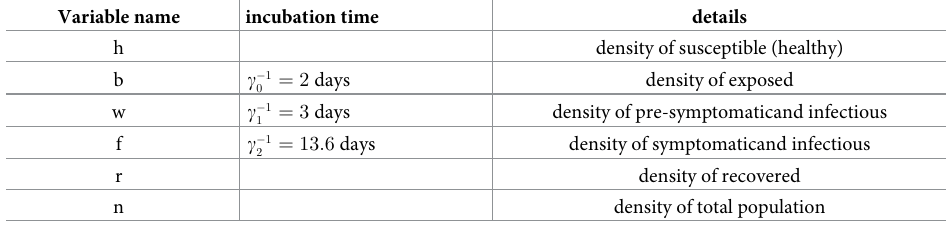
Table 2. Summary of variables of the model [Eqs (1) and (2)] and their respective time